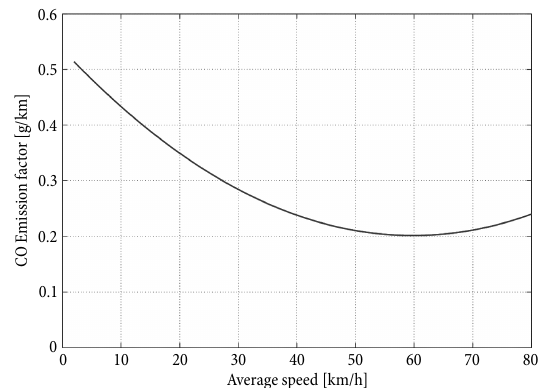
Average speed [km/h] Fig. 11. Emission factor function of CO pollution (passenger car equipped with a Euro 5 gasoline engine, under 1.4 L) network average speed and the number of vehicles in the network. fourth-order polynomial fitting was applied for the case